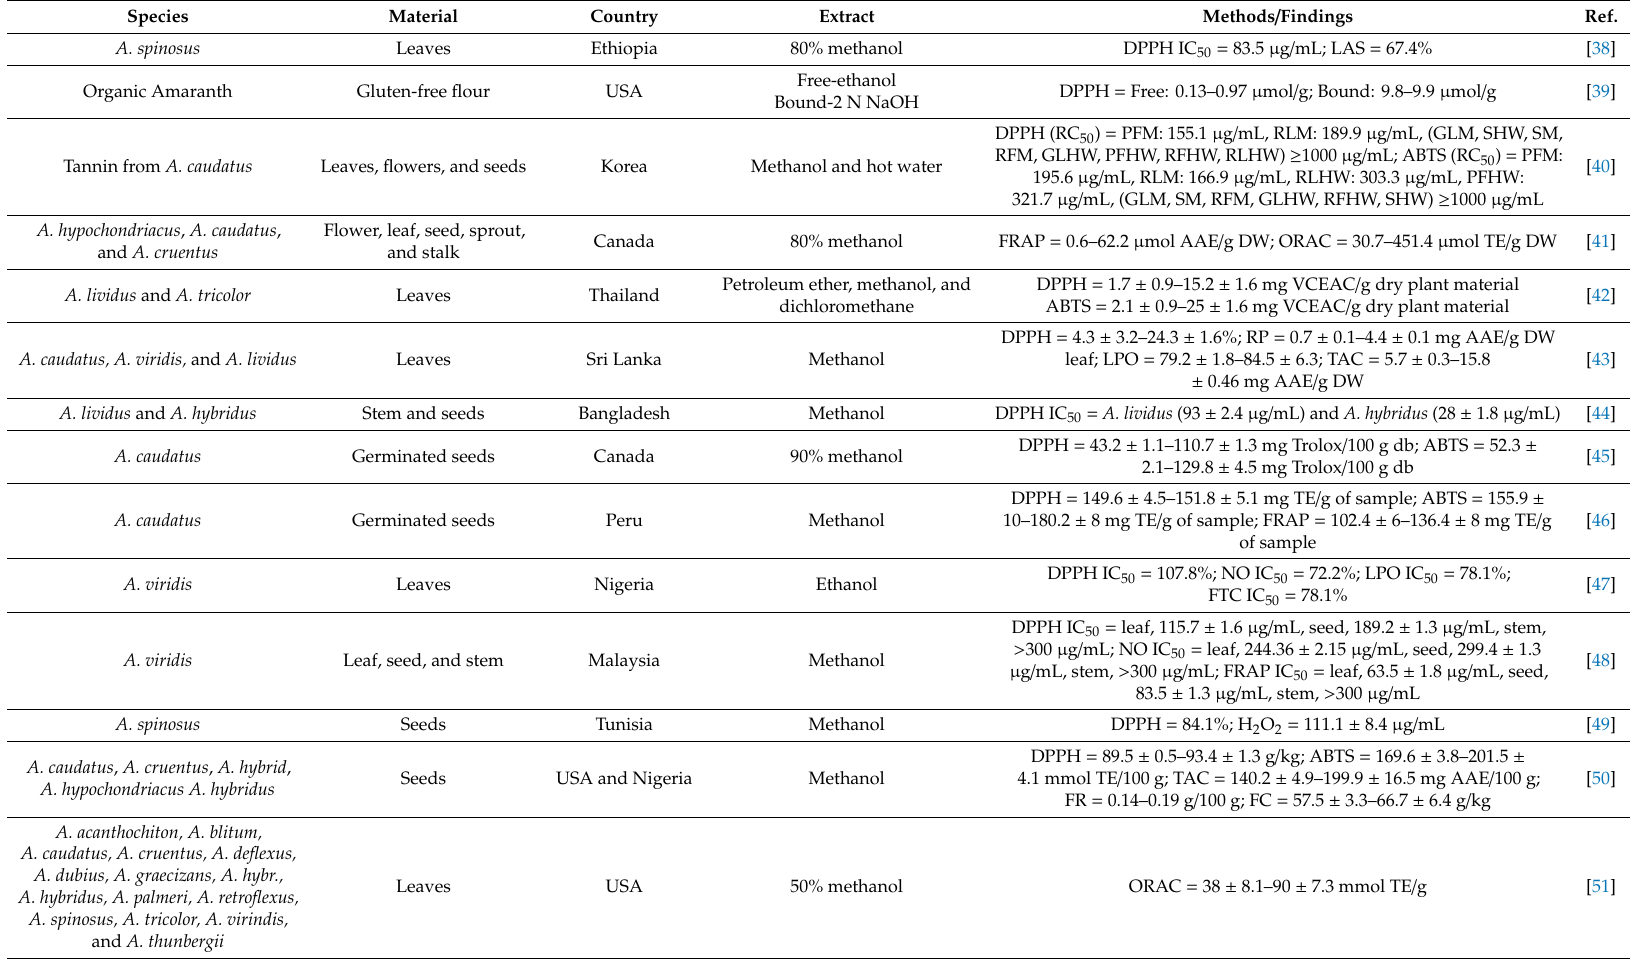
Table 1. Antioxidant and radical scavenging activity of Amaranthus